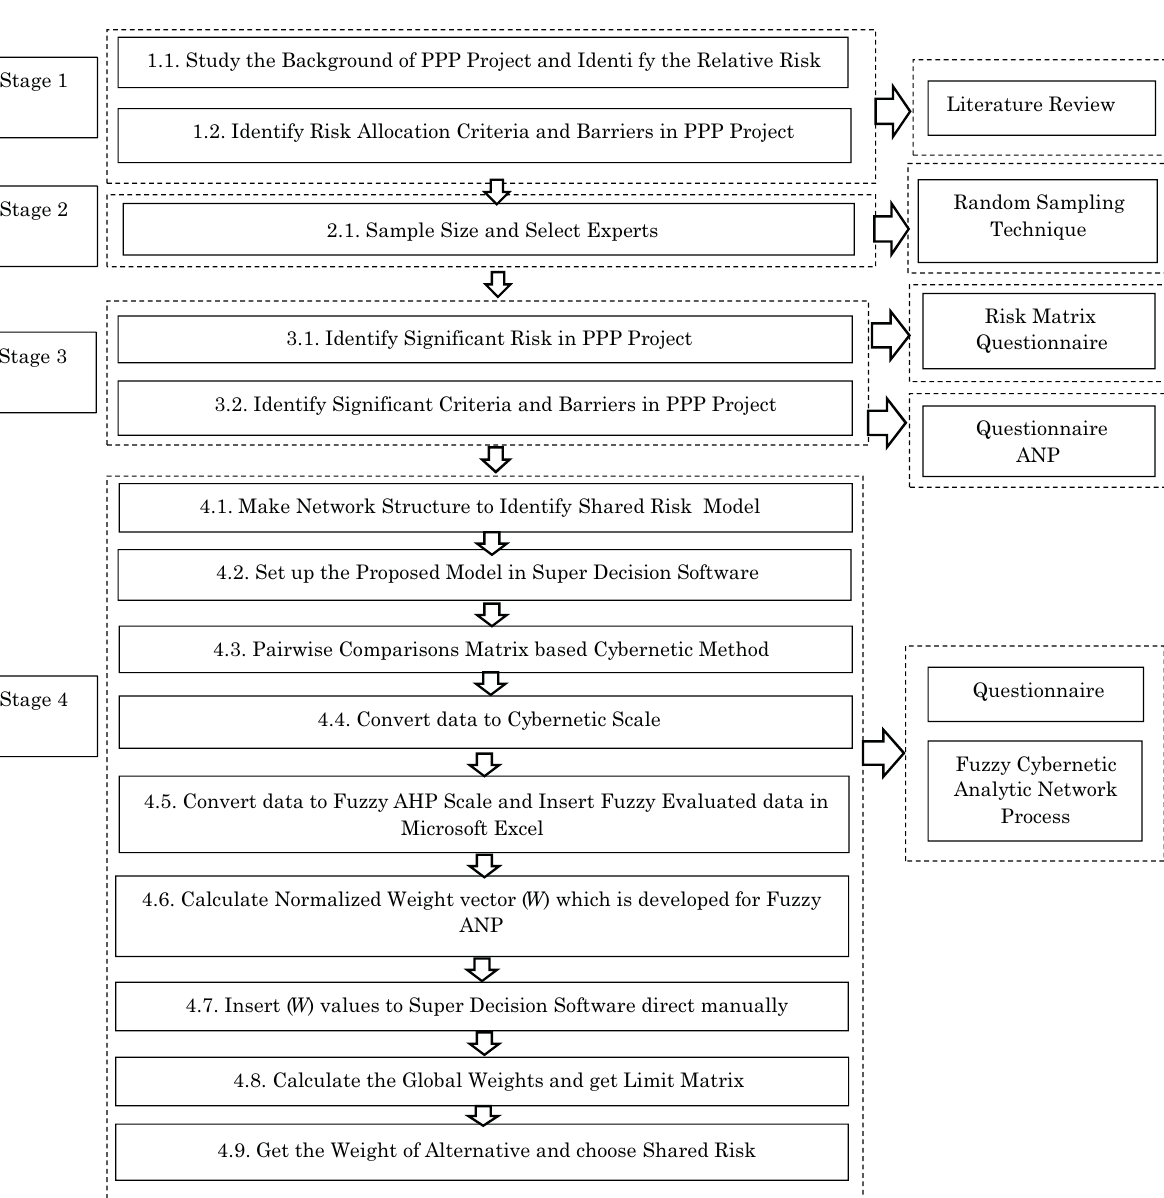
Fig. 1. Research methodology: stages and